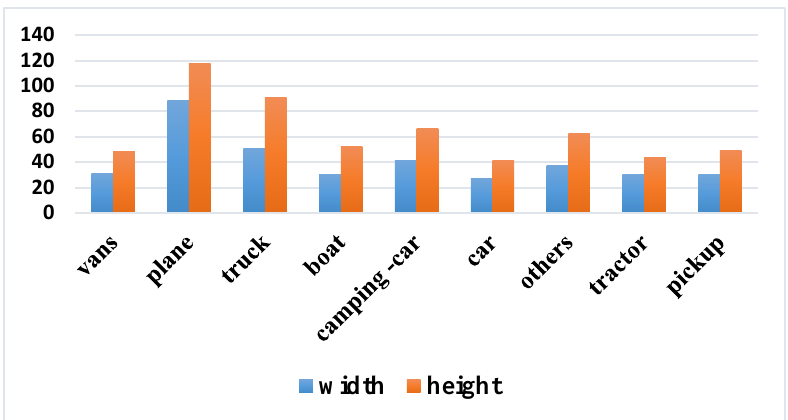
Figure 1. Average length and width of different vehicles in VEDAI dataset.